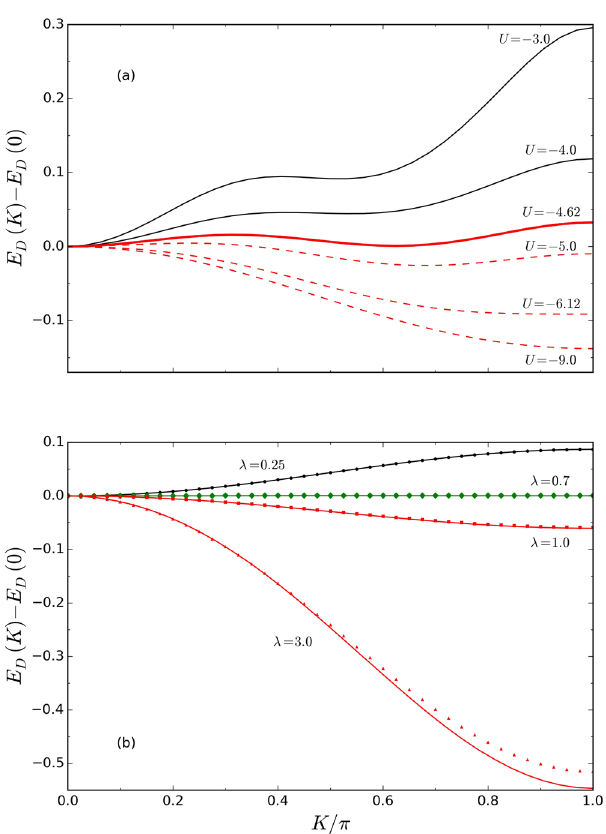
Figure 3. Dimer dispersion E D ( K ) − E D (0) for ( a ) λ = 1 and various values of U ; and ( b ) U = − 30 and various values of λ . In both cases t = 1, Ω = 3. The lines are the VED results and the symbols are the MA results. Note the sharp transitions of the GS momentum from K GS = 0 to K GS > 0 in both